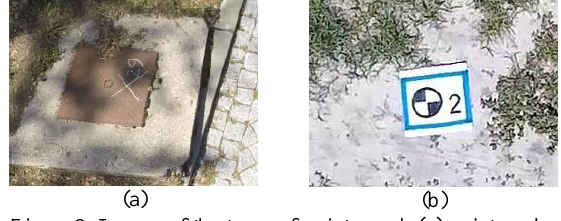
Figure 2. Images of the types of points used: (a) point marked with chalk and (b)